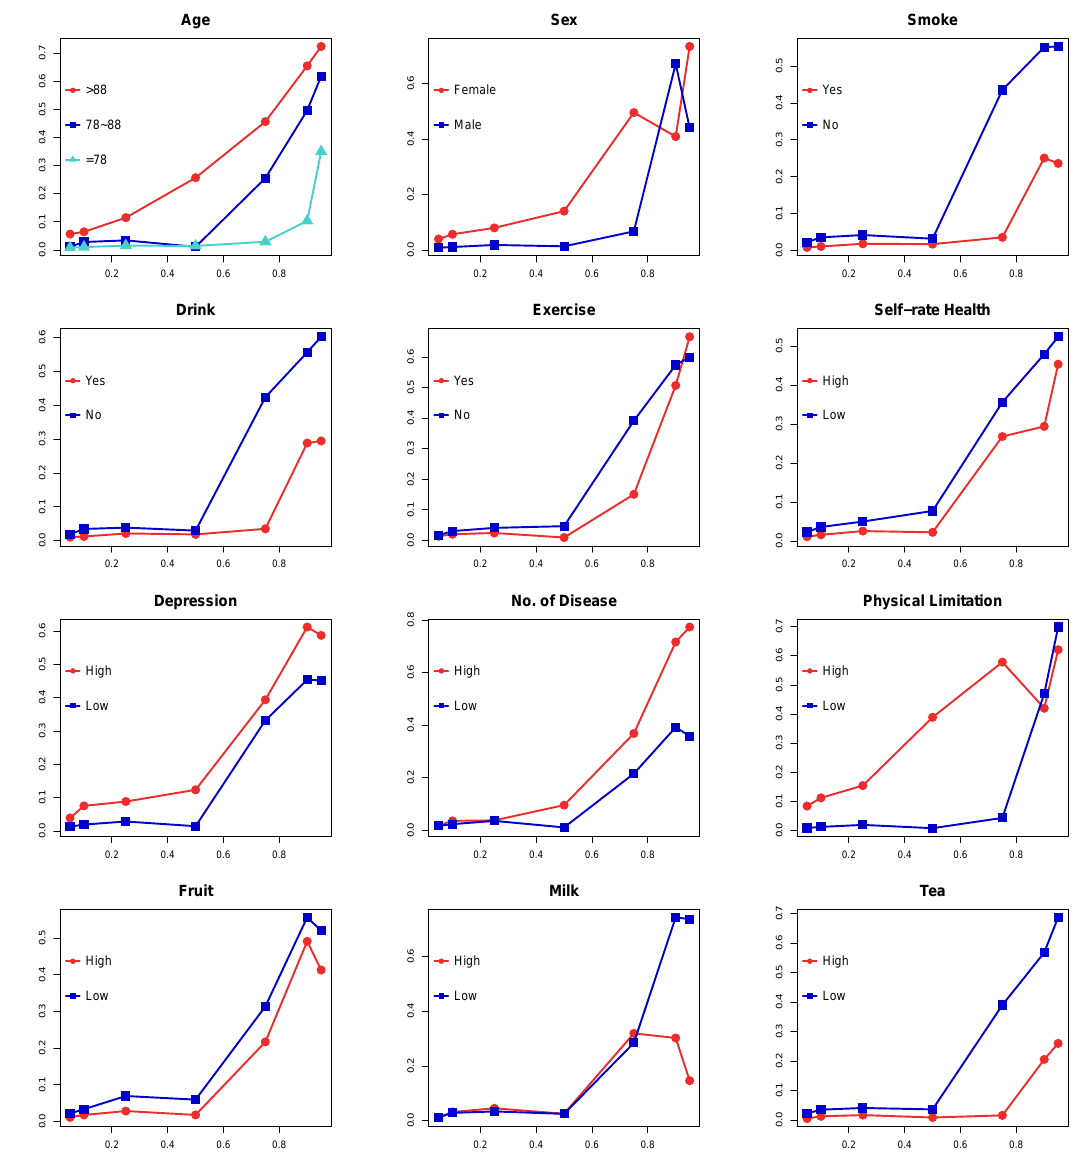
Figure 2. Coefficients of social vulnerability in subsamples. Note: Horizontal axis: quantiles of cognitive impairment, Vertical axis: coefficients of the social vulnerability